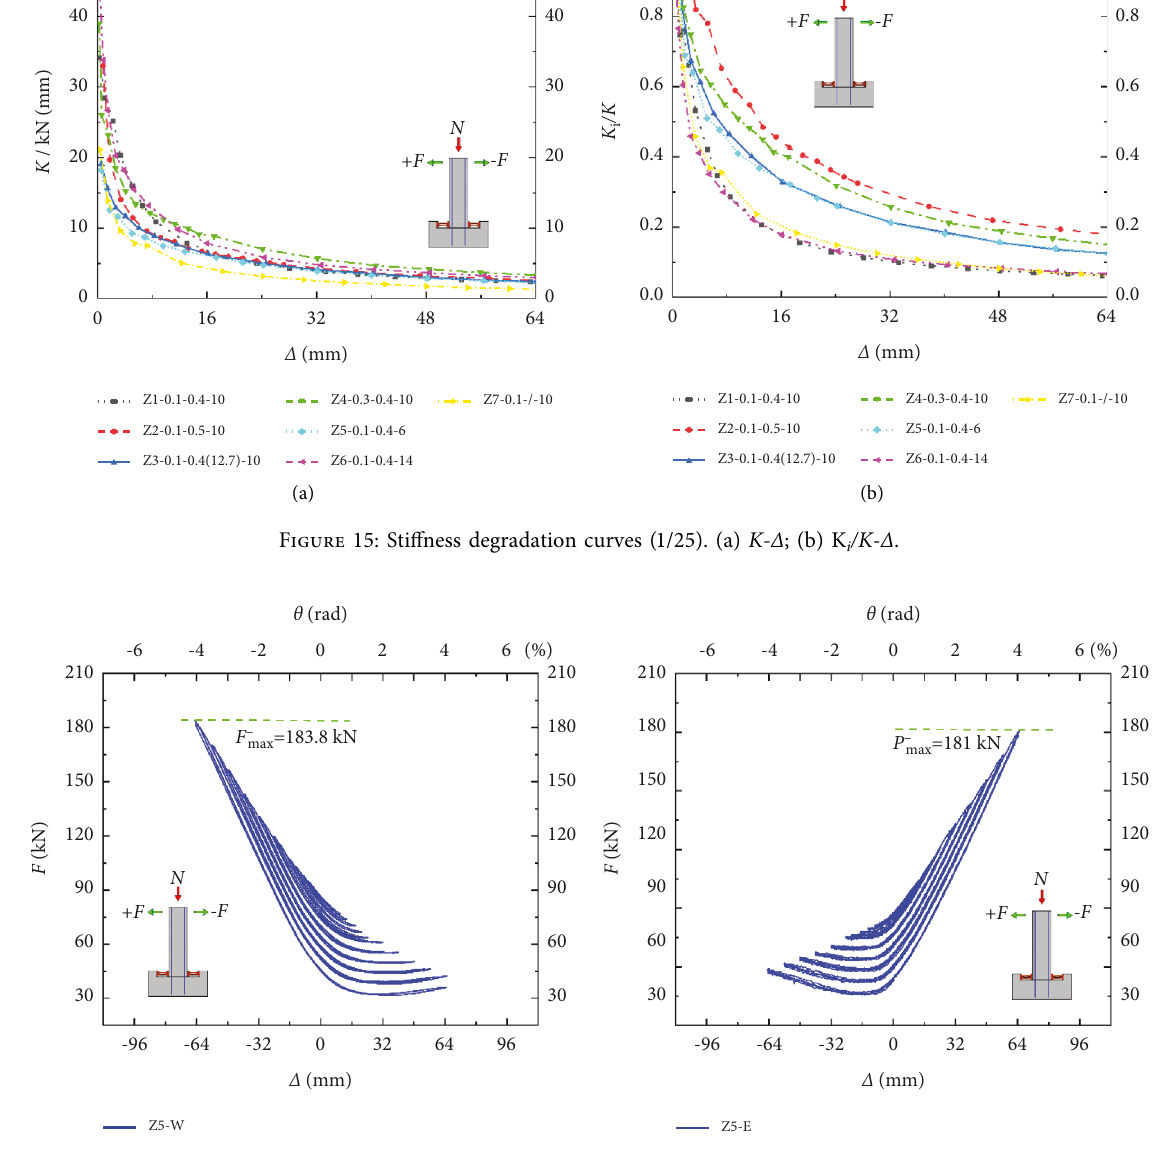
Figure 16: The prestressing forces vs. displacements for Specimen 5. (a) For the tendon at side A. (b) For the tendon at side